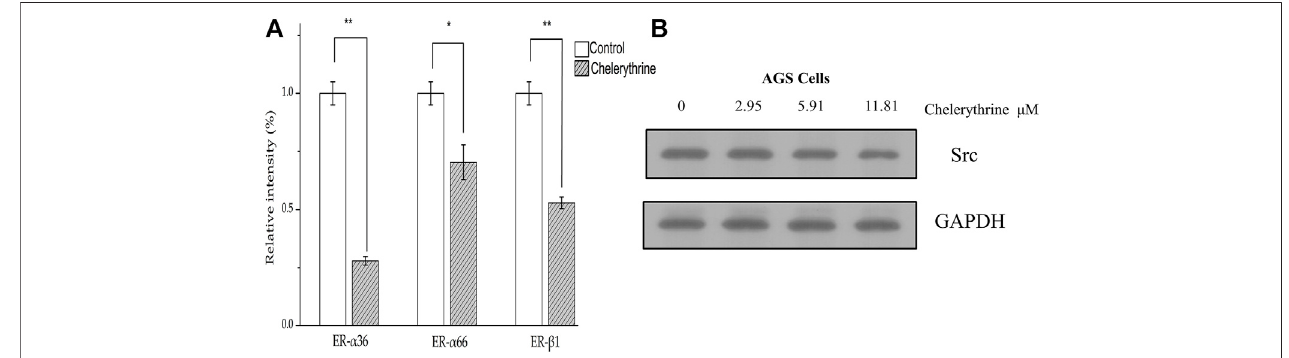
FIGURE 6 | Regulation on estrogen pathway. (A) Treated with Chelerythrine at 11.81 μ M or control for 48 h, mRNA levels of AGS were determined by quantitative PCR. The results were displayed as mean ± SD ( n = 3). p values, *: p < 0.05, **: p < 0.01. (B) Western blot of Src and GAPDH (internal reference) presented after being treated with Chelerythrine at 0, 2.95, 5.91, and 11.81 μ